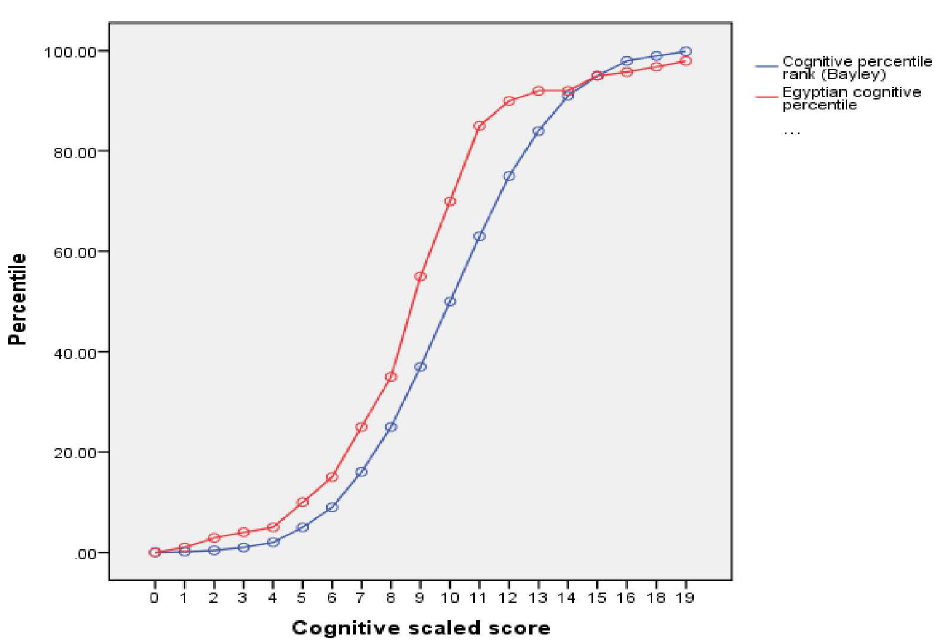
Fig 1. Egyptian versus American percentiles of the cognitive domain.